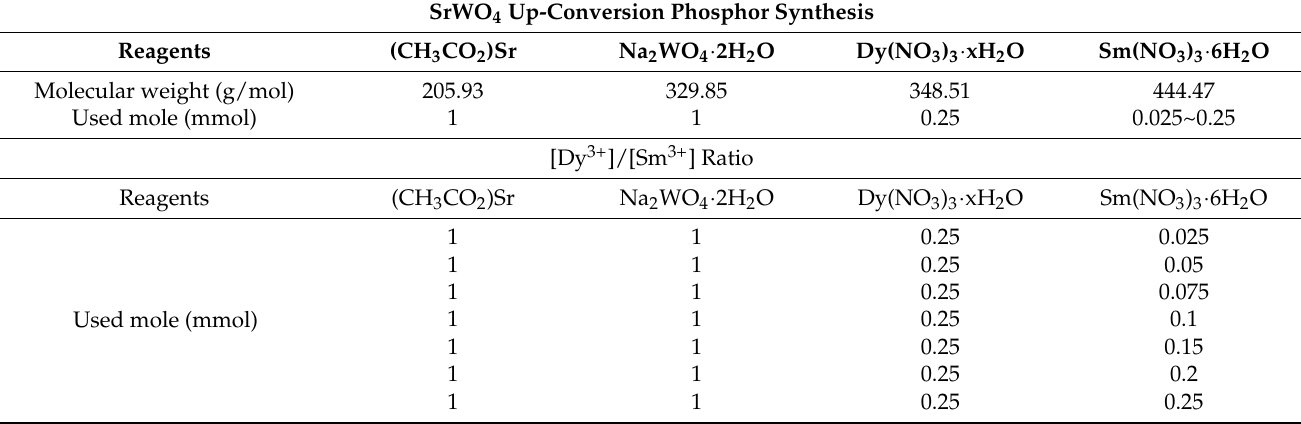
Table 1. Reagents and moles used in the